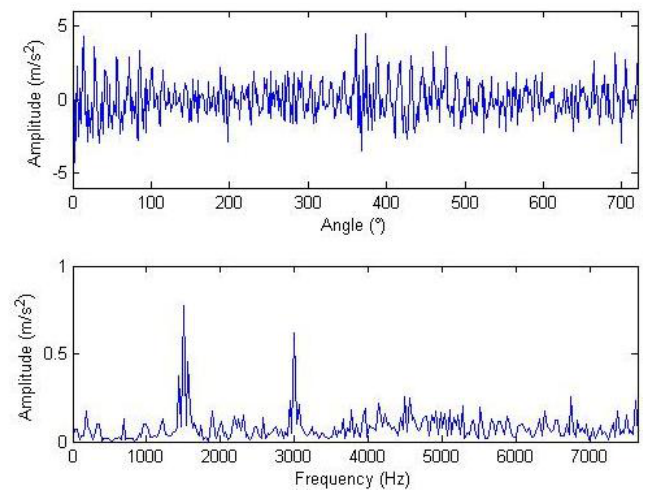
Figure 4. Waveform and frequency spectrum of reconstructed signals.